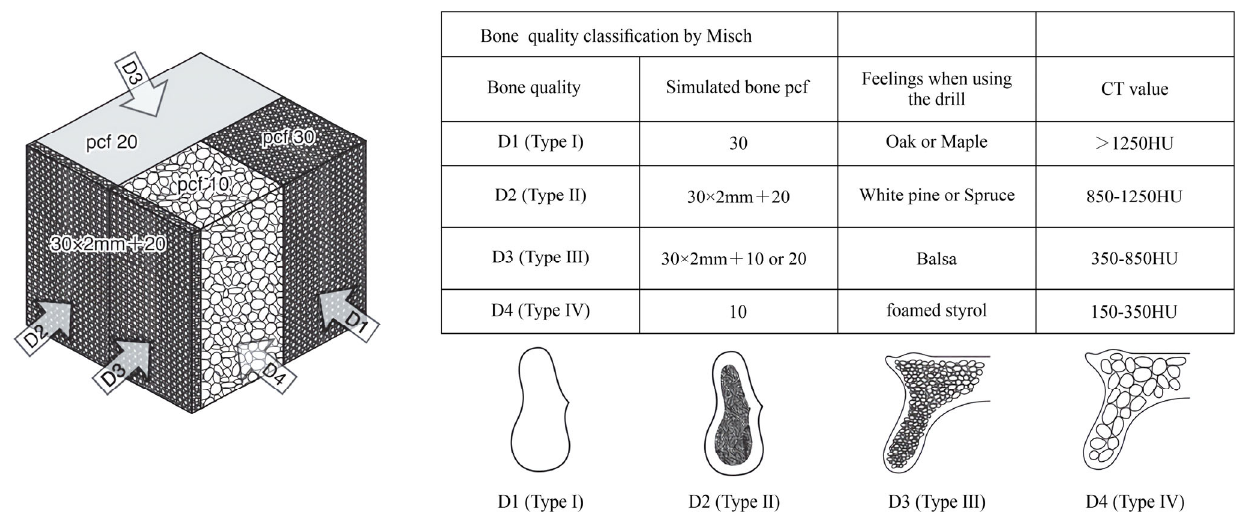
Figure 1. Training cube details. CT: computed tomography.